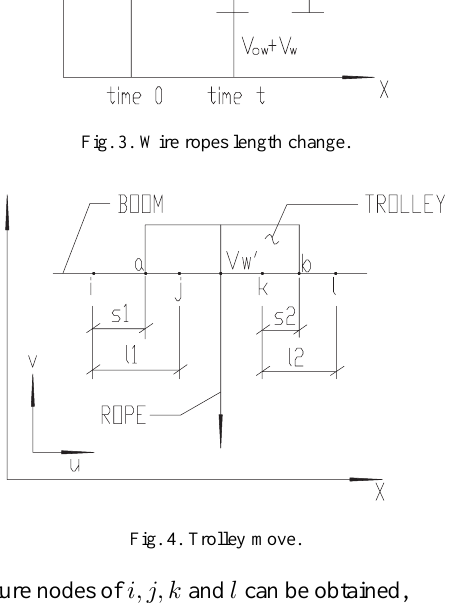
Fig. 3. Wire ropes length change.